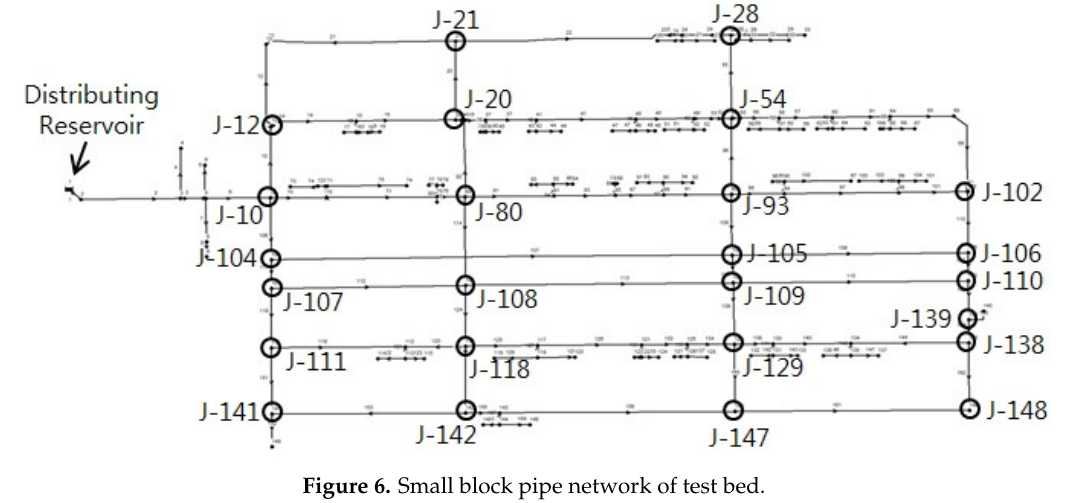
Figure 6. Small block pipe network of test bed. Table 12. Results of pressure contribution analysis for test bed.